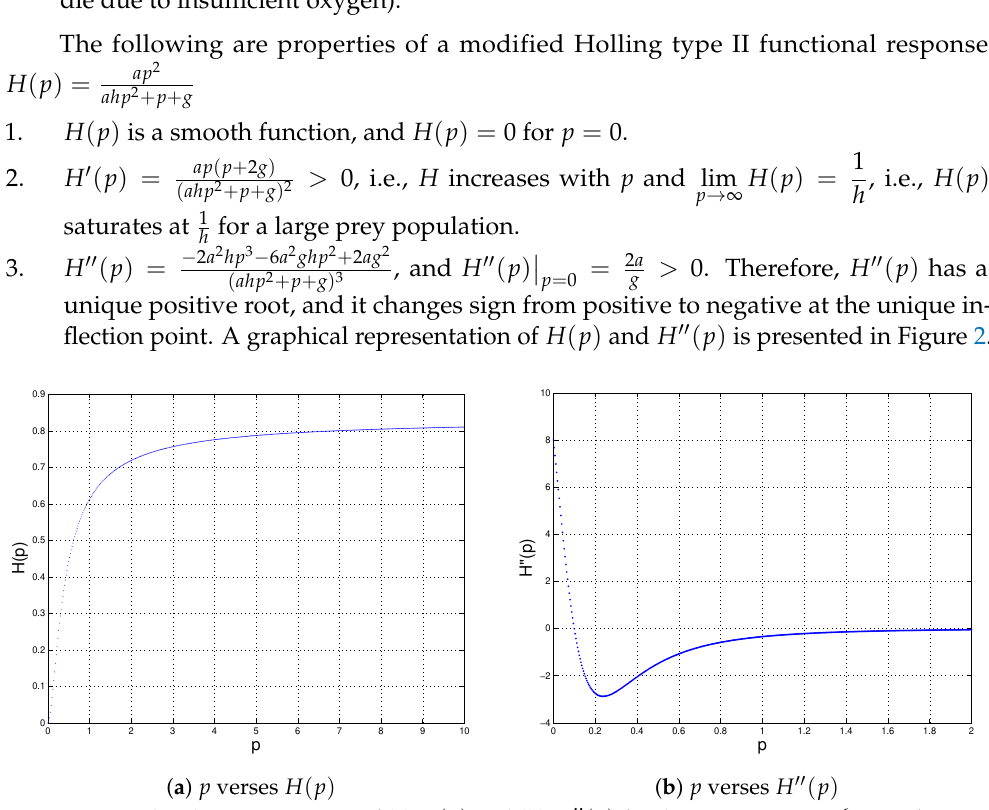
Figure 2. Graphical representations of ( a ) H ( p ) and ( b ) H (cid:48)(cid:48) ( p ) for the parametric set { a = 3, h = 1.2, g = 0.3 }